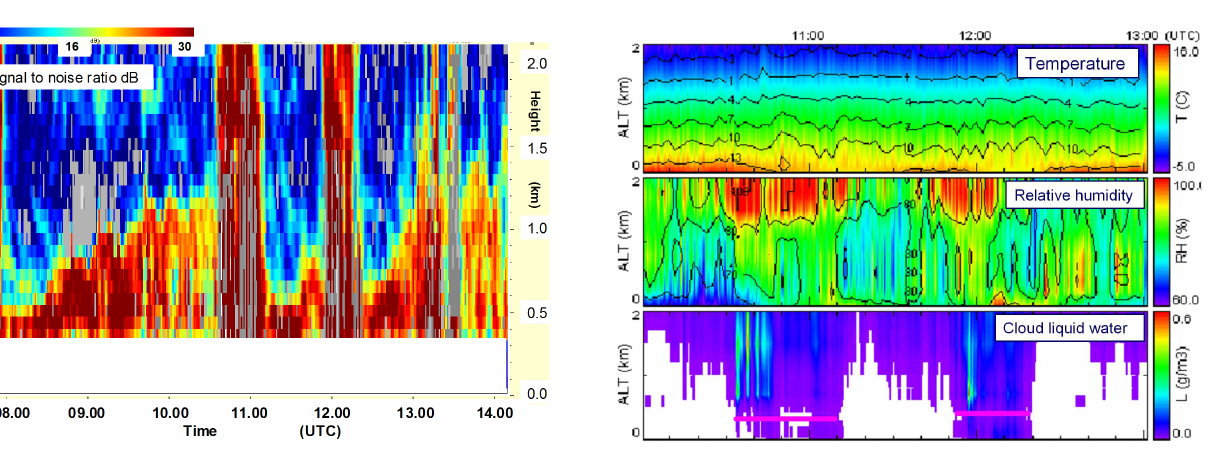
Fig. 10a. Signal to noise ratio measured by the wind pro- filer at Linkenholt 25 August 2005, 07:30–14:10UTC from 75 to 2150m a.g.l.